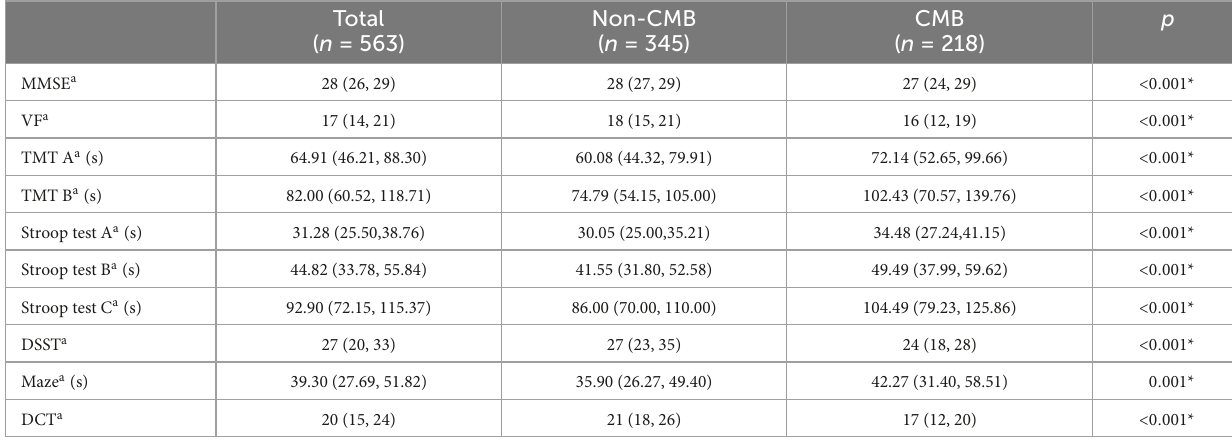
TABLE 2 Comparison of cognitive function between CMB and non-CMB